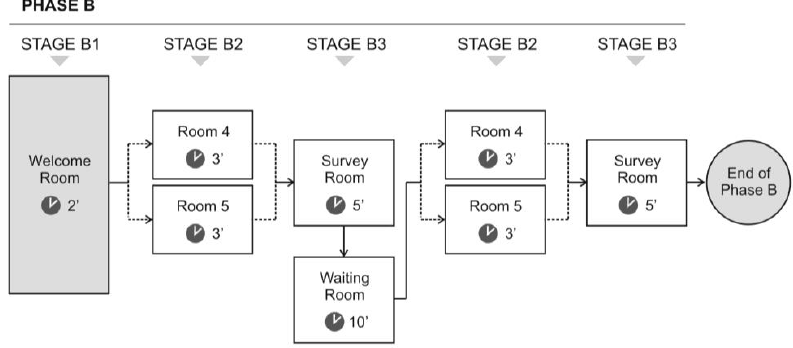
Figure 4. Flowchart for the experiment, showing all the stages in Phase B. 2.5.1. Phase A (Room 1: R, Room 2: VR, Room 3: